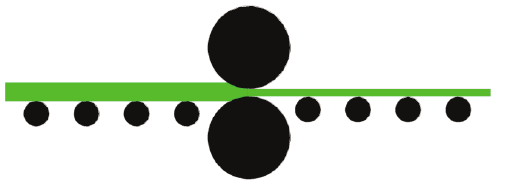
Fig. 3. Principle of the rolling mill